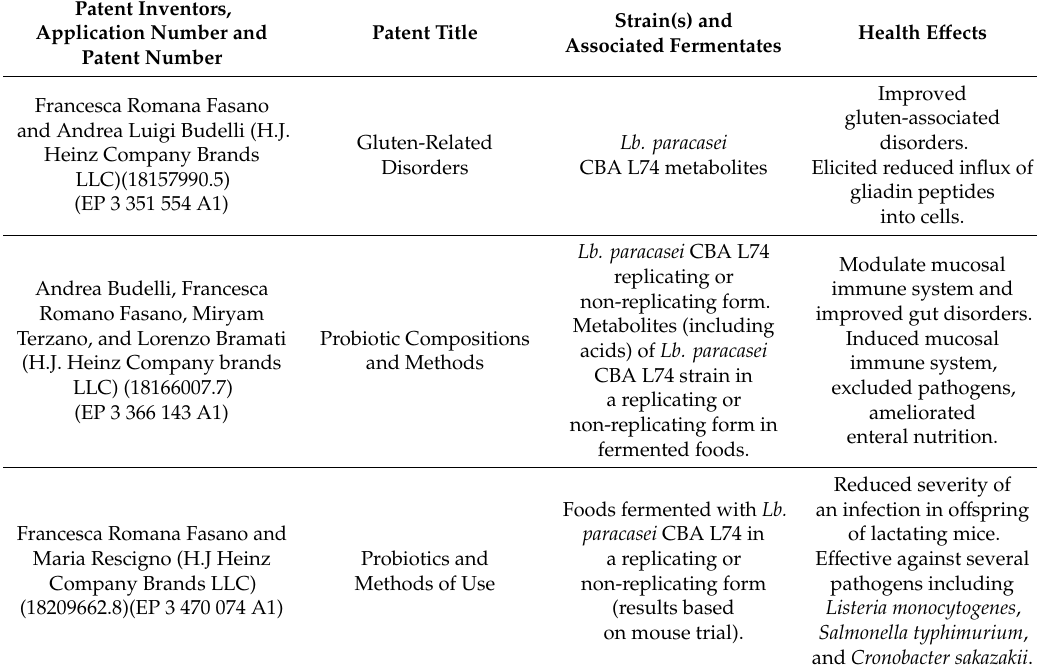
Table 1. Patents relating to health benefits of Lactic Acid Bacteria (LAB)